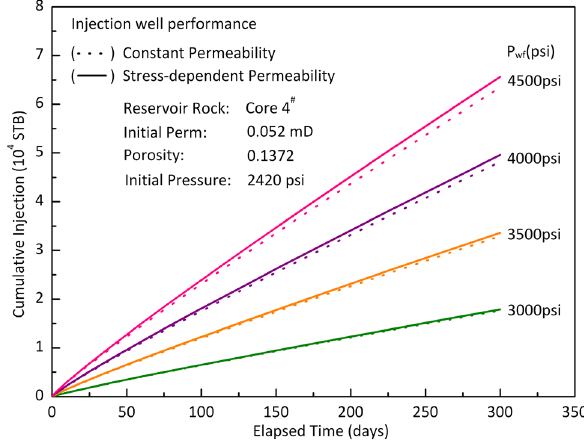
Fig. 8 Cumulative injection under different injection pressures